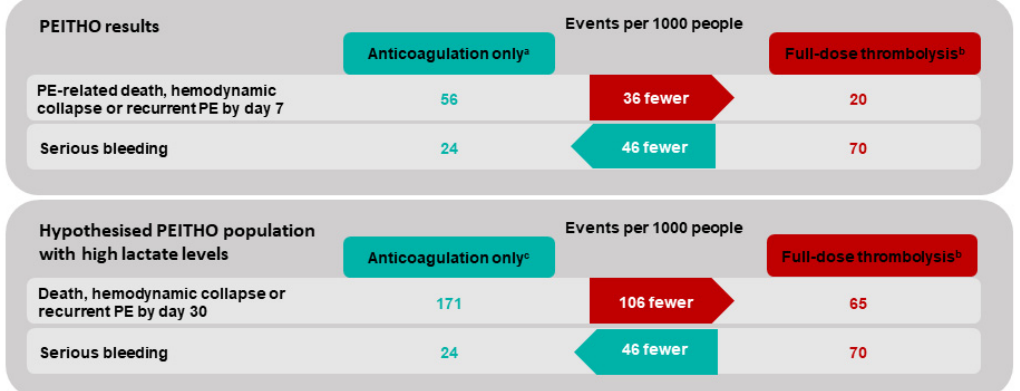
Figure 2. Extrapolated effect of full-dose thrombolysis in cohorts of patients with a different basal risk of an early adverse event. a Basal risk according to PEITHO trial [10], b relative effect according to Marti et al. [11]. c Basal risk obtained by combining the risk of the PEITHO population and the prognostic modulation obtained by adding lactate [60].